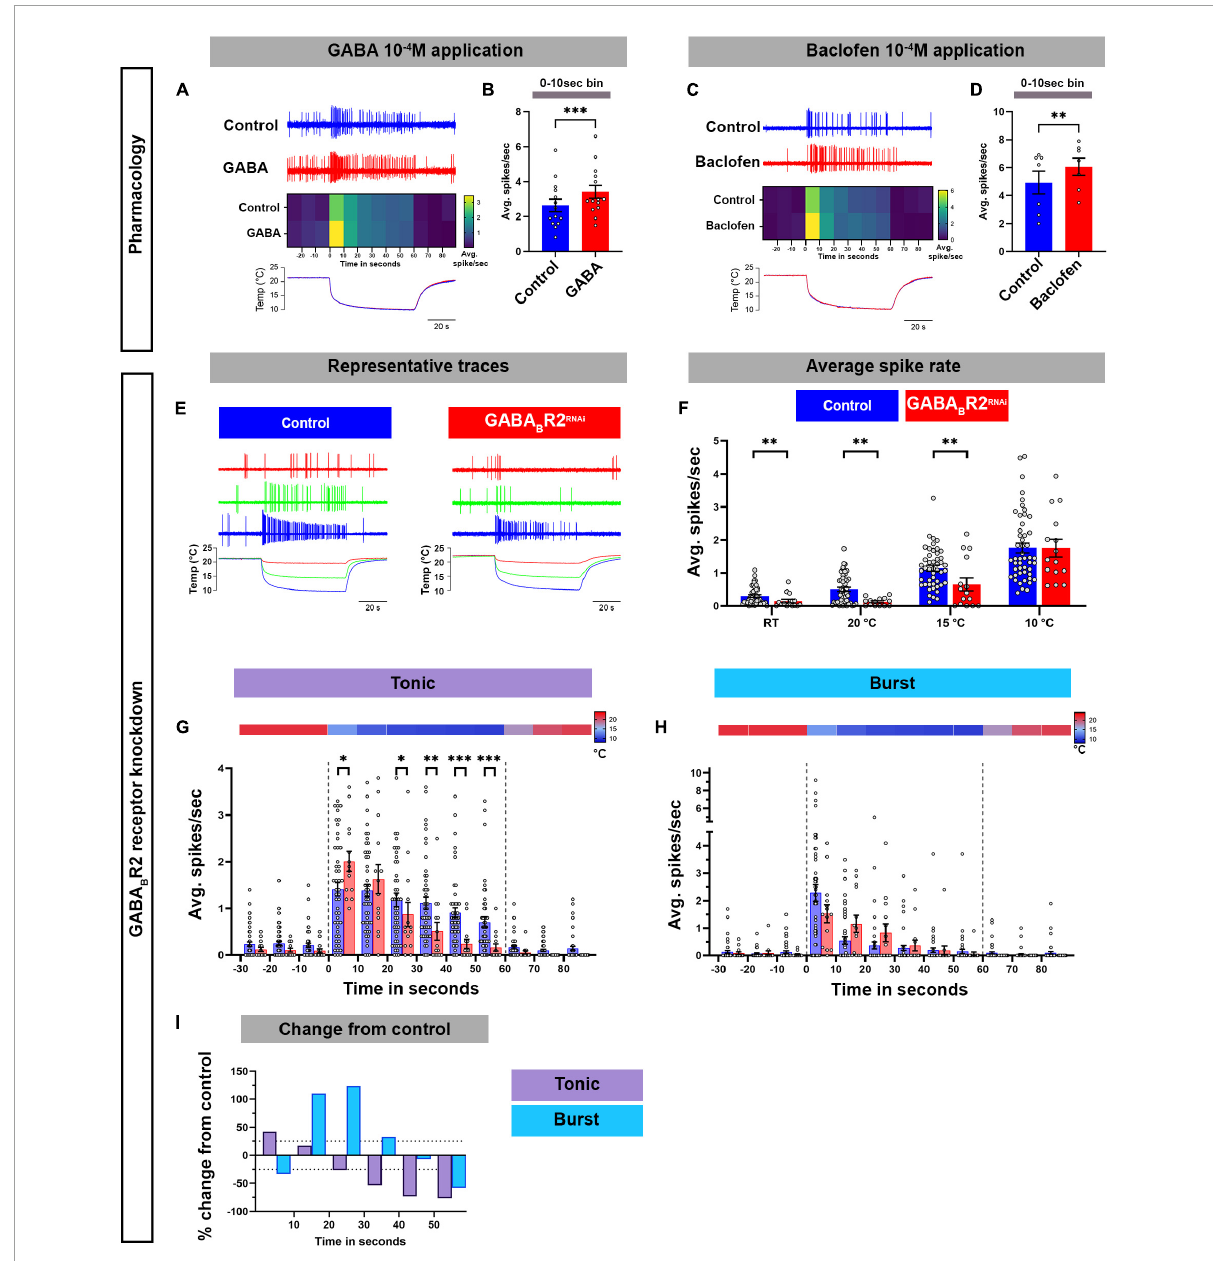
FIGURE5 GABA B -R2 receptor is required for proper composition of cold-evoked tonic and bursting pattern in CIII md neurons. (A–D) Assessing cold-evoked electrical responses of CIII md neurons upon (A,B) GABA or (C,D) baclofen application. (A,C) Representative traces of extracellular recordings of CIII md neuron upon cold exposure and (A) GABA 10 − 4 M or (C) baclofen 10 − 4 M application. The heatmap represents average spike rate (spikes/second) in 10 s bins. Below, line graph shows real time temperature (10 ◦ C) exposure regime of Drosophila larval filet. (B,D) Average spike rate during the first 10 s of stimulus delivery. GABA application: N Average = 14. Baclofen application: N Average = 7. Statistics: Paired t -test. (E–I) Electrical responses of CIII md neurons with GABA B -R2 knockdown. (E) Representative physiological firing traces of CIII md neurons with GABA B -R2 knockdown compared to controls during each stimulus temperature (20, 15, and 10 ◦ C) and below shows real time temperature exposure regimes of Drosophila larval filet. (F) Average spikes/seconds of CIII md neurons at room temperature (RT) or cold stimulations (20, 15, and 10 ◦ C). N Average = 32. Statistics: Multiple Mann–Whitney test with Benjamini, Krieger, and Yekutieli for multiple comparisons. (G,H) 10 ◦ C stimulus evoked tonic spike rate (G) and bursting spike rate (H) . Individual spikes are considered to bursts, if inter spike interval is less than 0.15 s for at least three spikes and rest of the spikes counted as tonic spikes. Heatmap above each graph represents stimulus temperature. Spike rate is calculated in 10 s bins. Statistics: Multiple Mann–Whitney tests with Benjamini, Krieger, and Yekutieli for multiple comparisons. (I) Percent change from control for bursting or tonic firing in GABA B -R2 knockdown. Significant differences indicated via asterisks, where ∗ p < 0.05, ∗∗ p < 0.01, and ∗∗∗ p <